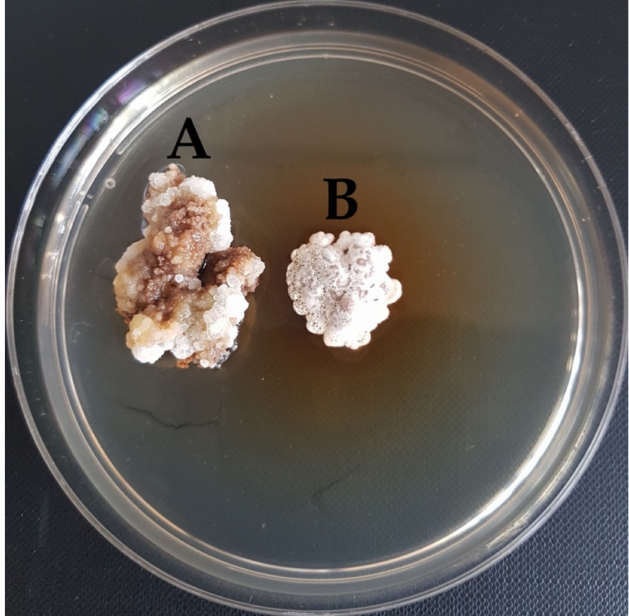
Figure 6. Interaction in in vitro dual culture between Fraxinus excelsior callus ( A ) and endophyte Thielavia basicola ( B ). The fungus did not kill the F. excelsior callus after 60 days of culturing without passaging. The mycelium of T. basicola developed a distinctive white coating that made the entry of hyphae into the tissues of the callus impossible. It is probable that the growth of mycelium was inhibited by the callus tissue producing secondary metabolites. During culturing the tree tissue remained fully viable and optimally hydrated. The endophyte also caused a yellow staining of the MS medium